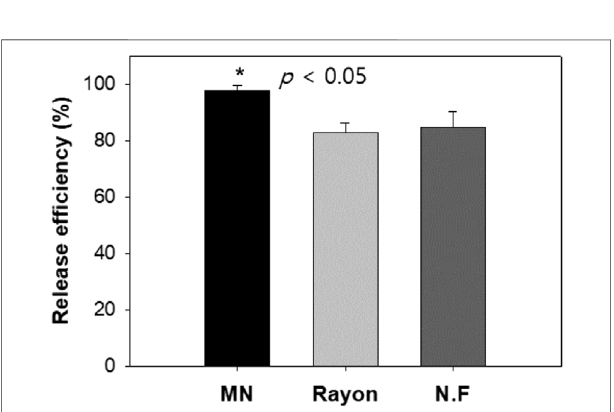
FIGURE 12 | Comparison of release ef fi ciency (%) observed for three swabs(theamountofDNAreleasedintosolutionat1 minfromtotalamountof DNA collected by swabs): MN: microneedle swab, Rayon: rayon swab, N.F: nylon fl ocked swab (n = 4).